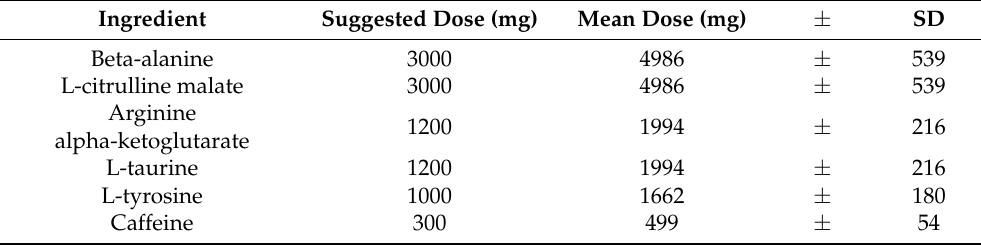
Table 1. Producer’s suggested doses and mean used in the study—body-weight-adjusted doses of specific MIPS